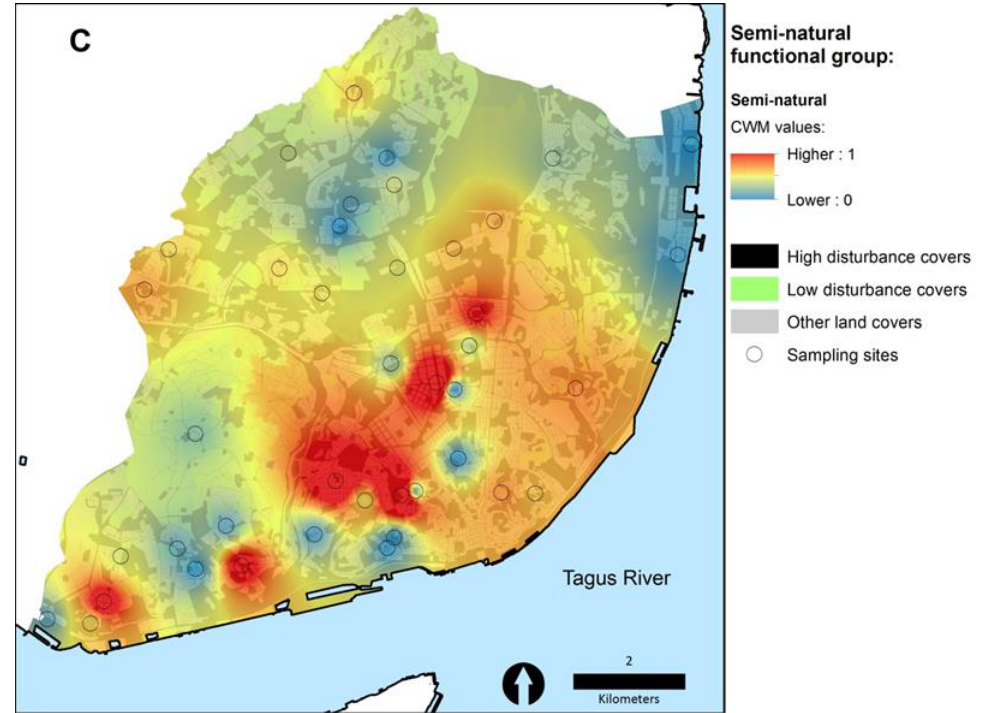
Figure 4. Spatial interpolation of the community weighted mean (CWM) values of the three functional groups of the poleotolerance trait in the 41 sampling sites in Lisbon: ( A ) represents the pattern of high disturbance functional group CWM; ( B ) the low disturbance functional group CWM. Areas colored in a gradient from blue to red signal represent increasing values of CWM. ( C ) The CWMs of the seminatural functional group. Areas colored in a gradient from blue to red signal represent increasing values of CWM. Empty circles indicate the sampling sites. Land cover details can be seen in Table S4.